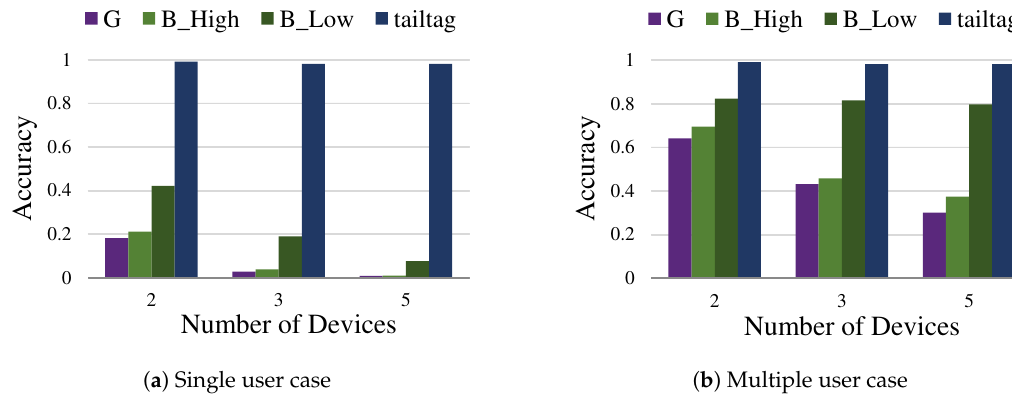
Figure 12. Accuracy by Framework: ( a ) the test result of multiple devices of a single user; and ( b ) the test result of multiple devices of multiple users (where only one device is registered for the user saying the hotword). The x -axis denotes the number of devices and the y -axis denotes the accuracy. The test was performed 100 times for each combination of five testers, four compared solutions, and the number of